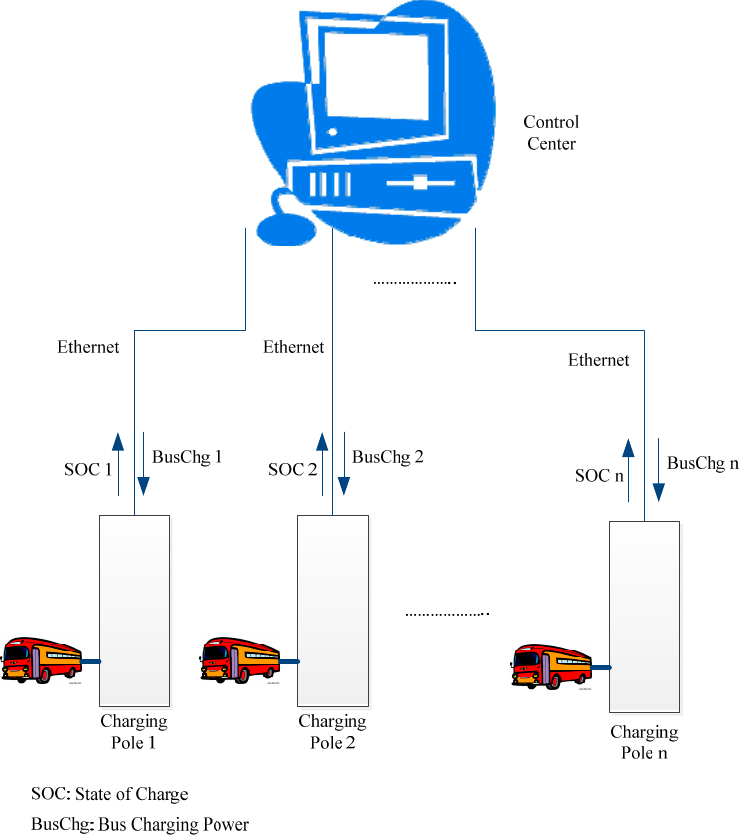
Figure 6. Implementation of the proposed model in the field.